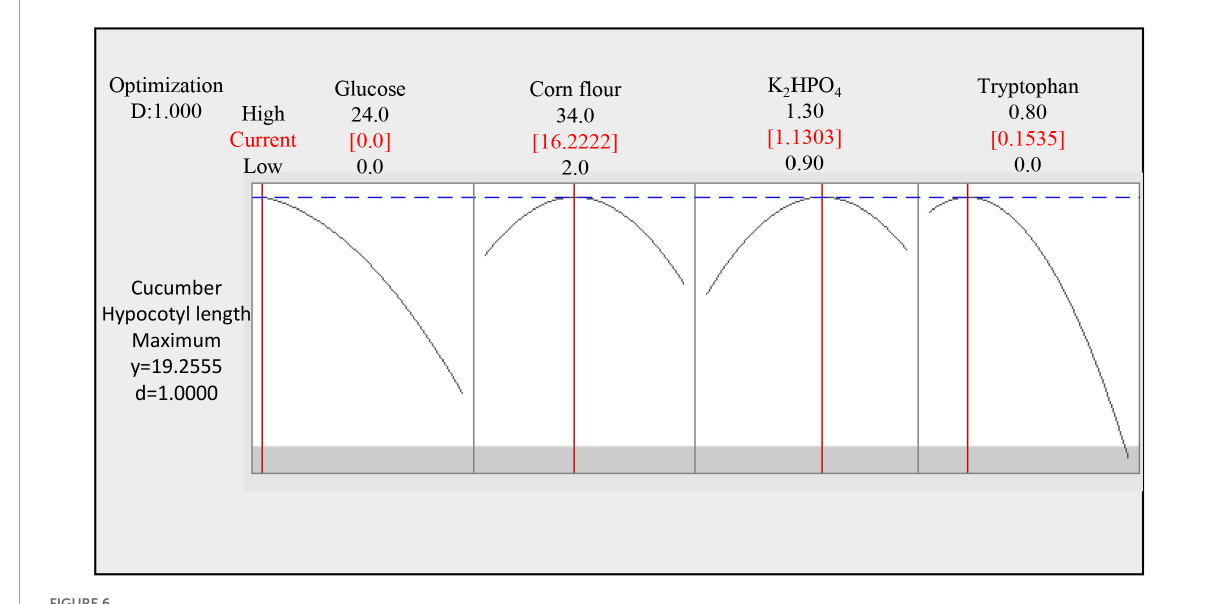
FIGURE6 Optimal medium concentration of four significant factors selected by response surface methodology.